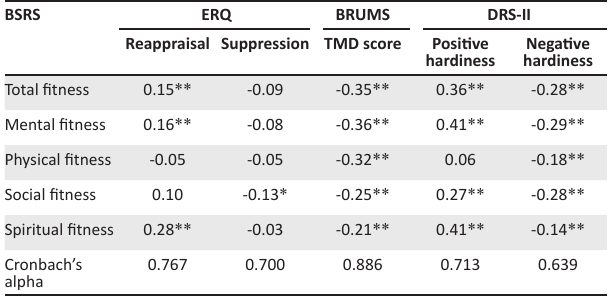
TABLE 5: Brief Sailor Resiliency Scale construct validity coefficients and Cronbach’s alphas.